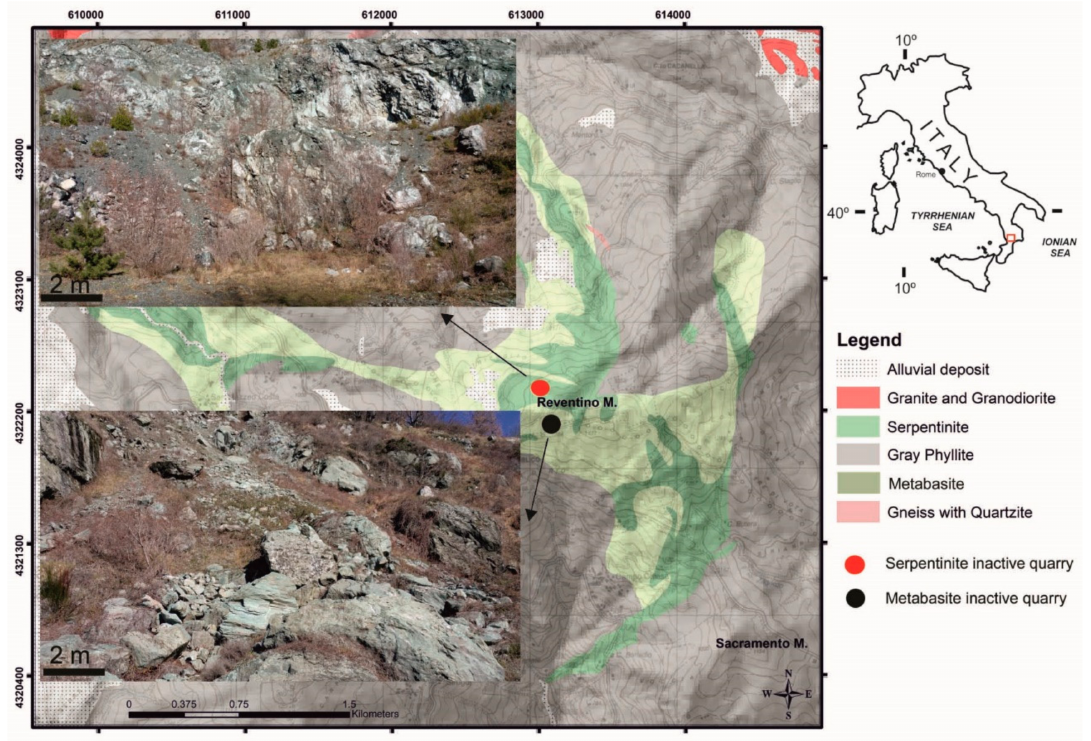
Figure 1. Simplified geological map of the investigated area with the location of measurement sites (after, [15]), in the upper left corner distant view of the serpentine inactive quarry; bottom left distant view of metabasite inactive quarry. The geographic position of the quarries are indicated by Universal Transverse Mercator (UTM)